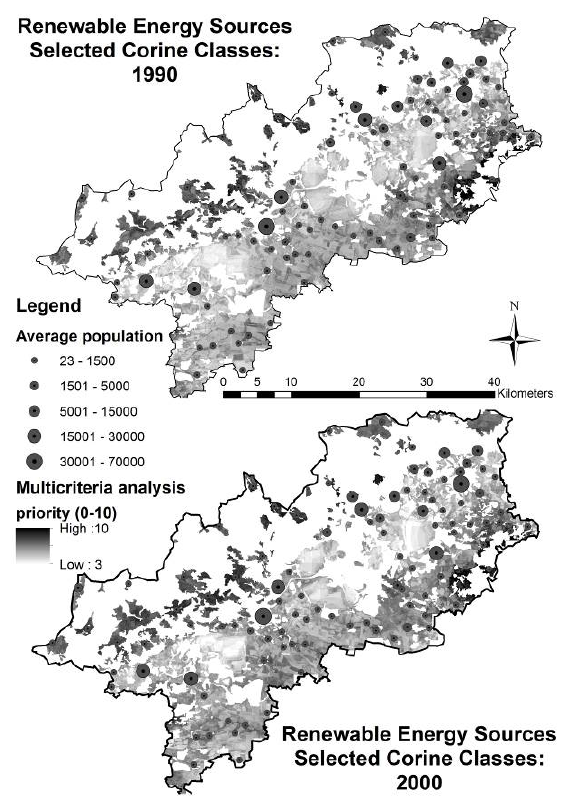
Figure 8. Moderate changes in mapping of suitable sites for utilization of renewable energy sources in 1990 and 2000.